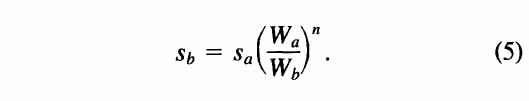
FIGURE 4 Typical linear least squares fit through response data.